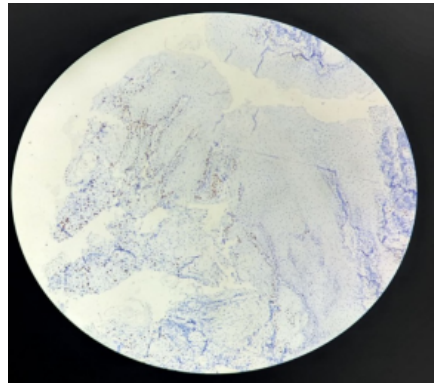
Figure 4. Photomicrograph of Ki67 immunohistochemical stain illustrating grade 2 positivity with 16% positivity (10x view)